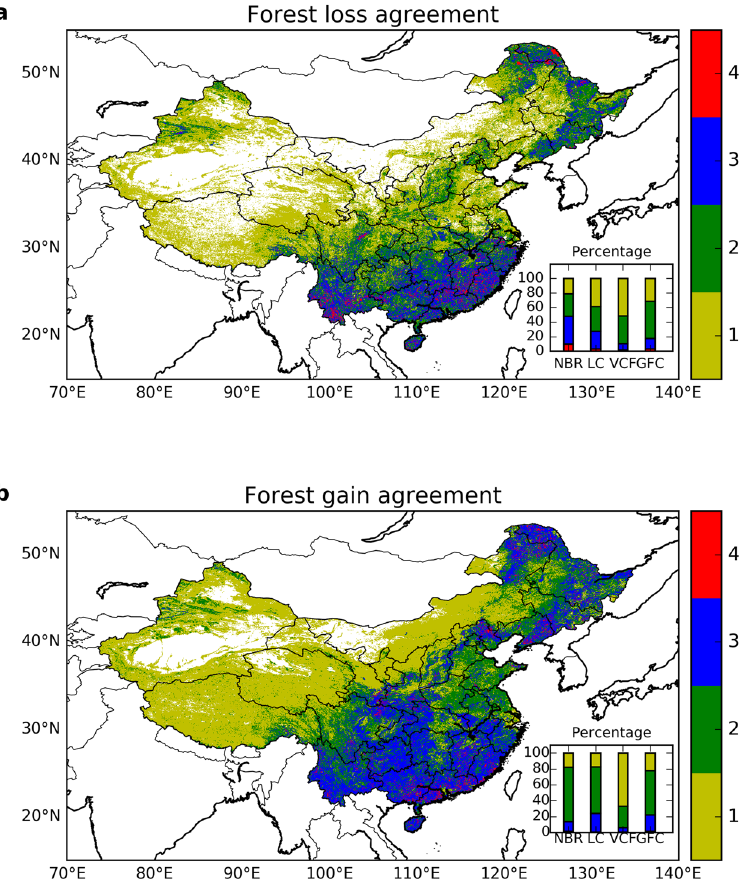
Figure 2. Forest cover change agreement among four satellite datasets: ( a ) Forest loss agreement and ( b ) forest gain agreement. The quantities represent the number of datasets that agreed in the direction of forest cover change among the four datasets. For each pixel, zero (white color) means no change was detected by any dataset whereas four means the change was detected by all four datasets. The stacked barplots in the lower right insets show the percentage of agreement of each dataset. For MODIS VCF and GFC, pixels with non-zero tree cover change were considered to be forest loss or gain. Maps were created using Python 2.7.11